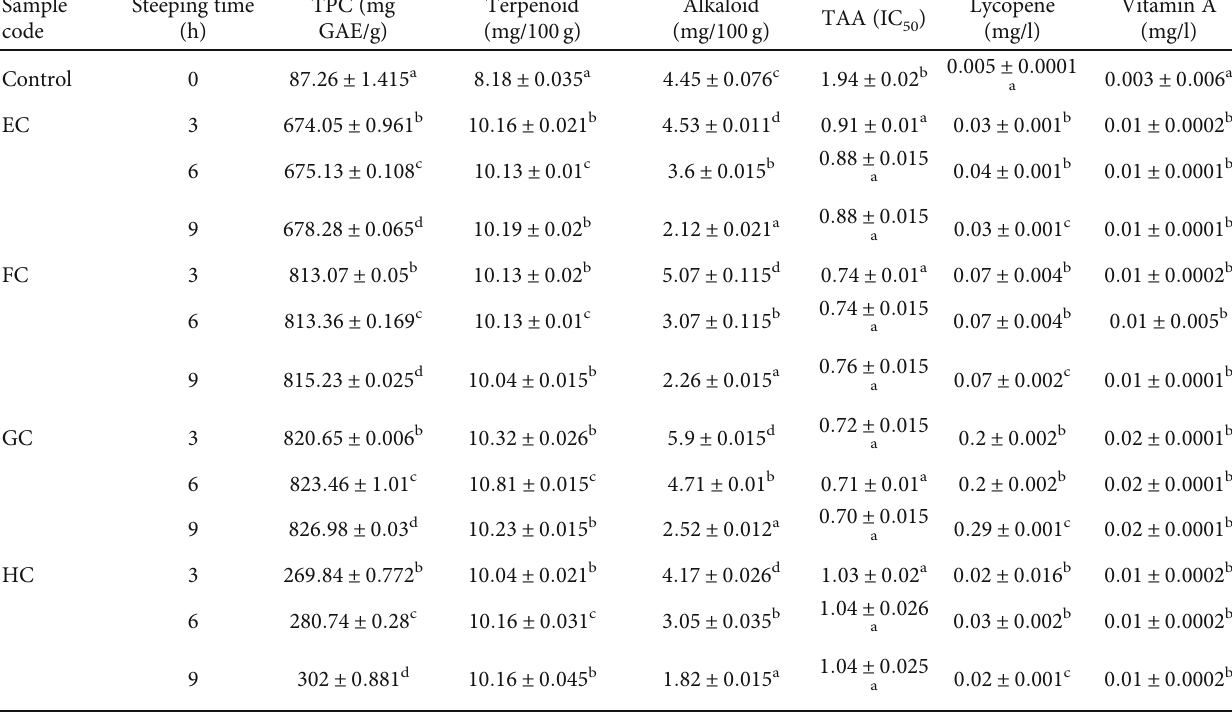
Table 4: Antioxidant properties of the cassava-cowpea-orange- fl eshed sweet potato (OFSP) blend. Sample